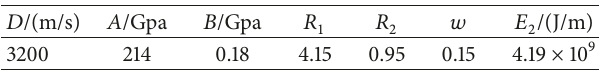
Table 3: Explosive and JWL state equation parameters